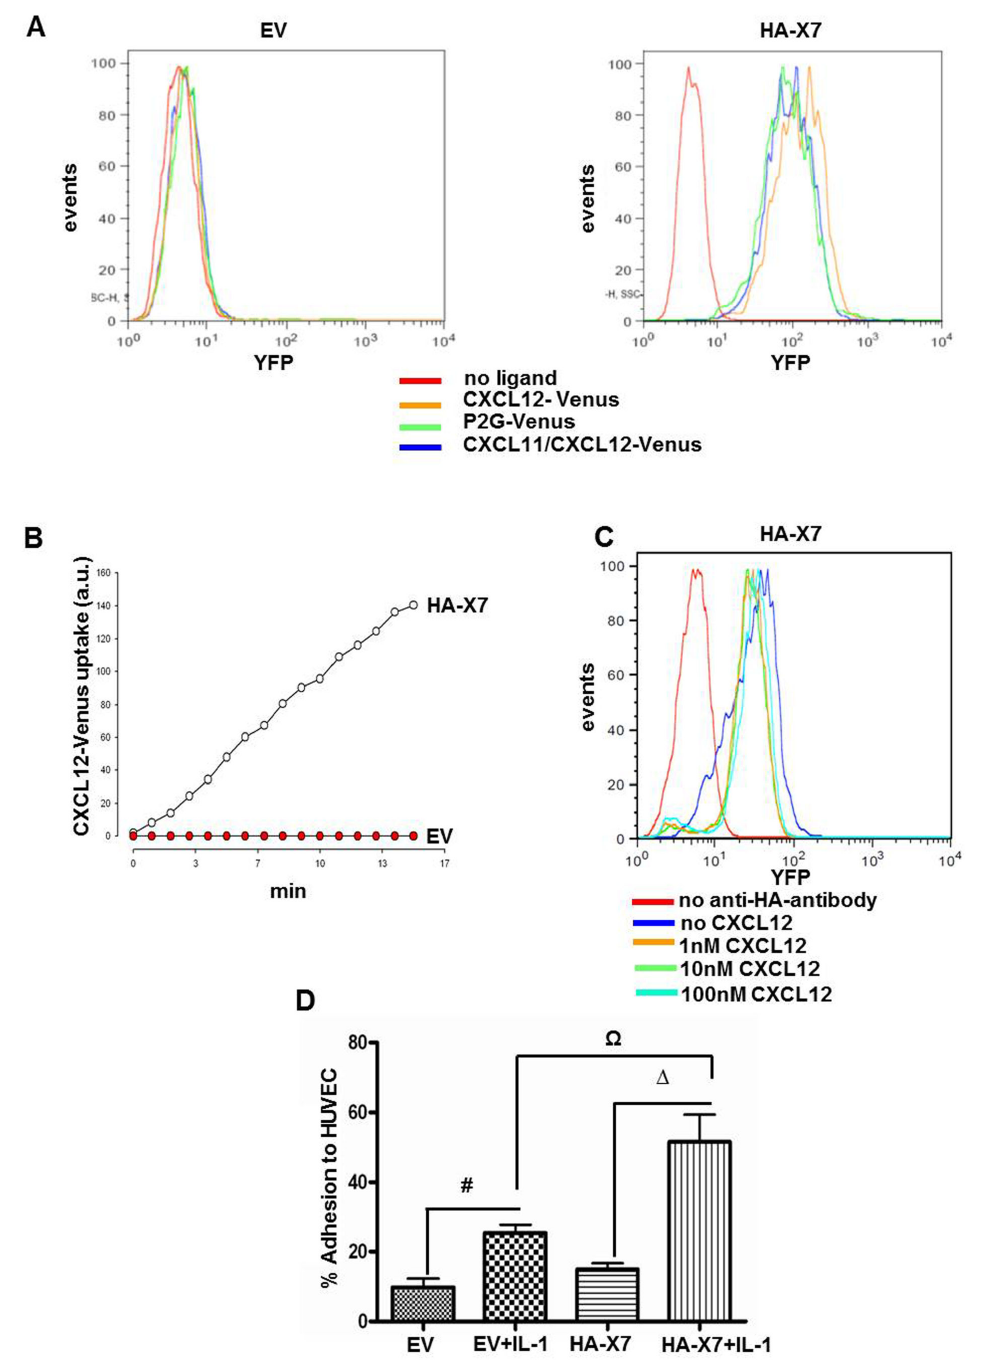
Figure 2. HA-CXCR7 overexpression in 143B OS cells enhanced CXCL12 scavenging and adhesion to HUVEC. (A) FACS analysis showed efficient scavenging of fluorescent Venus-tagged CXCL12 (orange profile), CXCL12 antagonist P2G (green profile) and chimeric CXCL11-CXCL12 (blue profile) in 143B- LacZ -HA-X7 (HA-X7), but not in control 143B- LacZ -EV (EV) cells. Controls in the absence of fluorescent ligands (red profiles). (B) Time-dependent uptake of CXCL12-Venus by 143B- LacZ -HA-X7 (○), assessed by time-laps confocal microscopy was not observed in 143B- LacZ -EV (●) cells. (C) CXCL12 at indicated increasing concentrations provoked minimal loss of HA-CXCR7 at the surface of 143B- LacZ -HA-X7 analyzed by FACS. (D) 143B- LacZ -HA-X7 (HA-X7) cells exhibited enhanced adhesion to interleukin-1β activated HUVEC compared to 143B-LacZ-EV cells. #,Ω,Δ indicate significant differences (p<0.05) between indicated cell lines and conditions. Values represent the mean ± SEM (n=3). doi: 10.1371/journal.pone.0074045.g002 PLOS ONE |